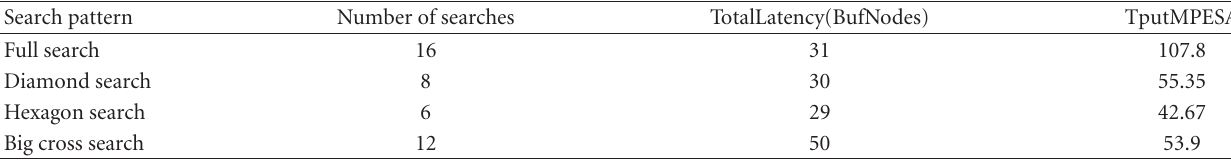
Table 4: MPESA throughput (in terms of number of pixels per clock cycle).